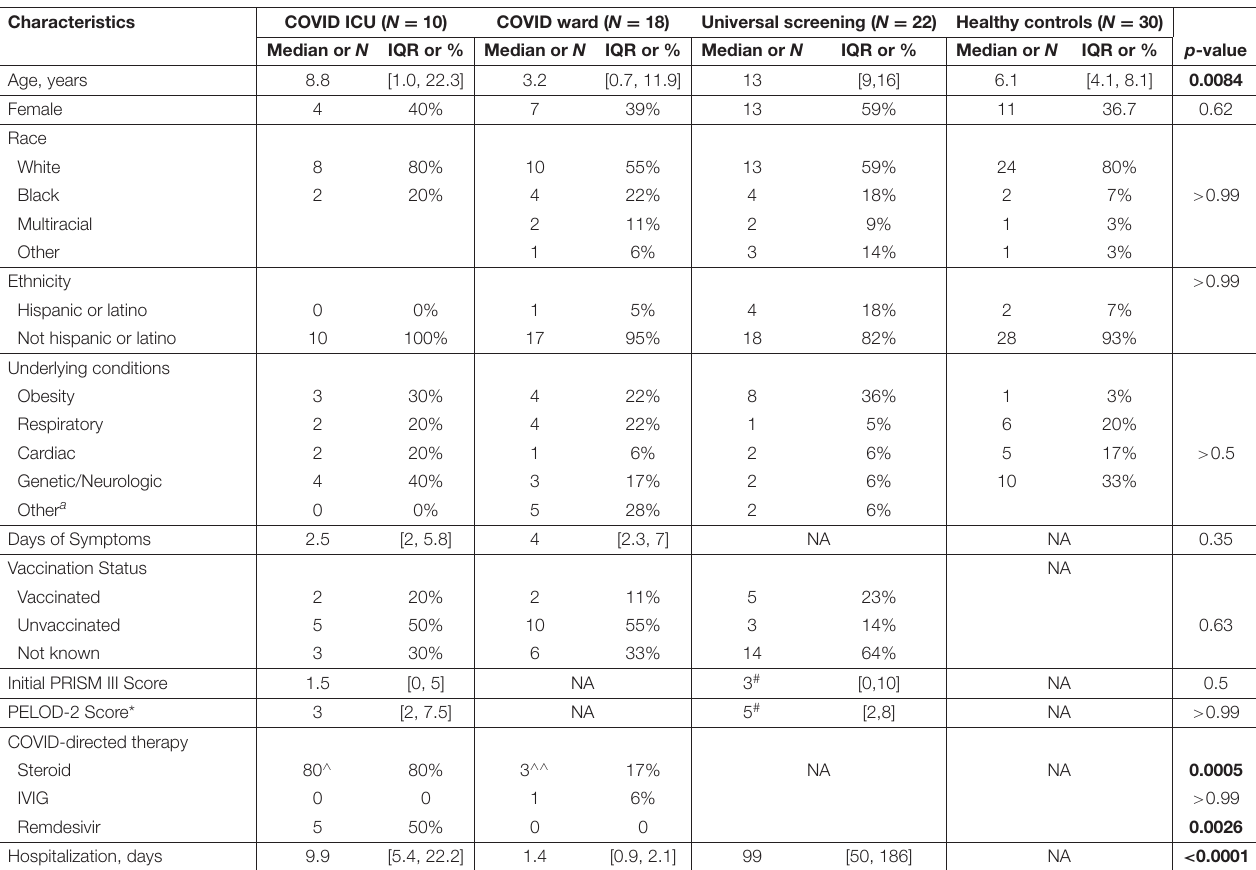
TABLE 1 | Characteristics of children with SARS-CoV-2 and healthy